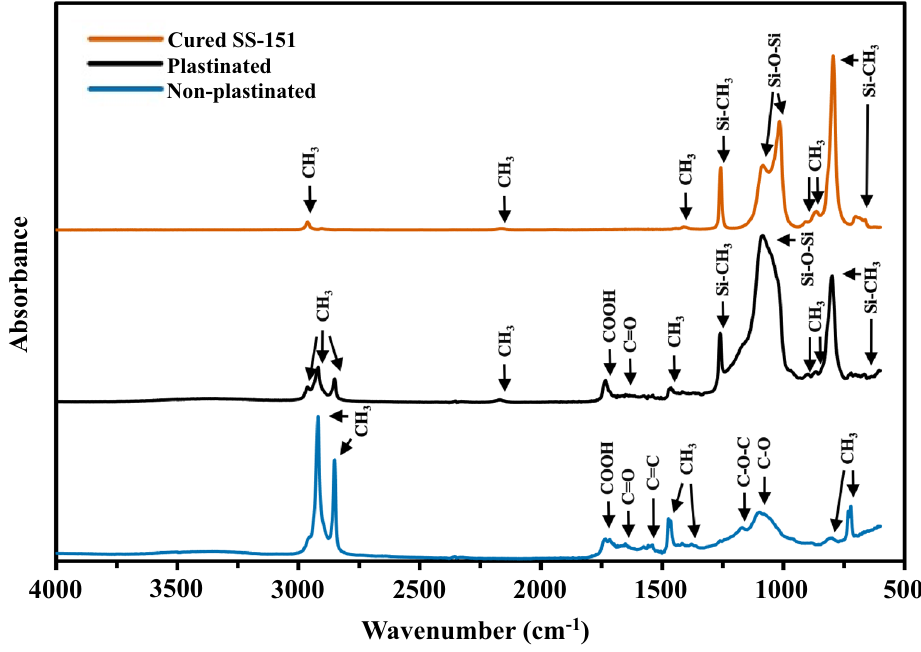
Figure 7. The FTIR analysis results of a cured piece of SS-151 silicone resin, a plastinated bamboo specimen, and a non-plastinated bamboo